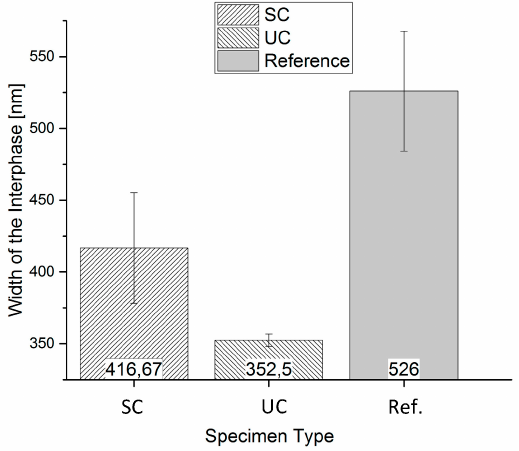
Figure 4. Interphase width for the influence of the fiber sizing measured with the introduced nano-scratch method with sized fibers (SC) and unsized fibers (UC).